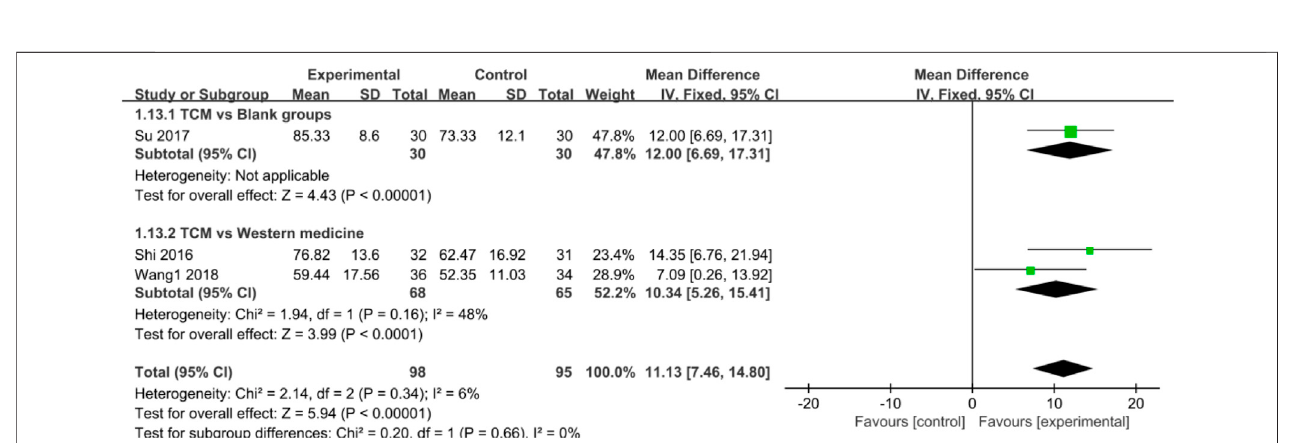
FIGURE 9 | Forest plot: CHM improved AF in CHD with depression compared with control